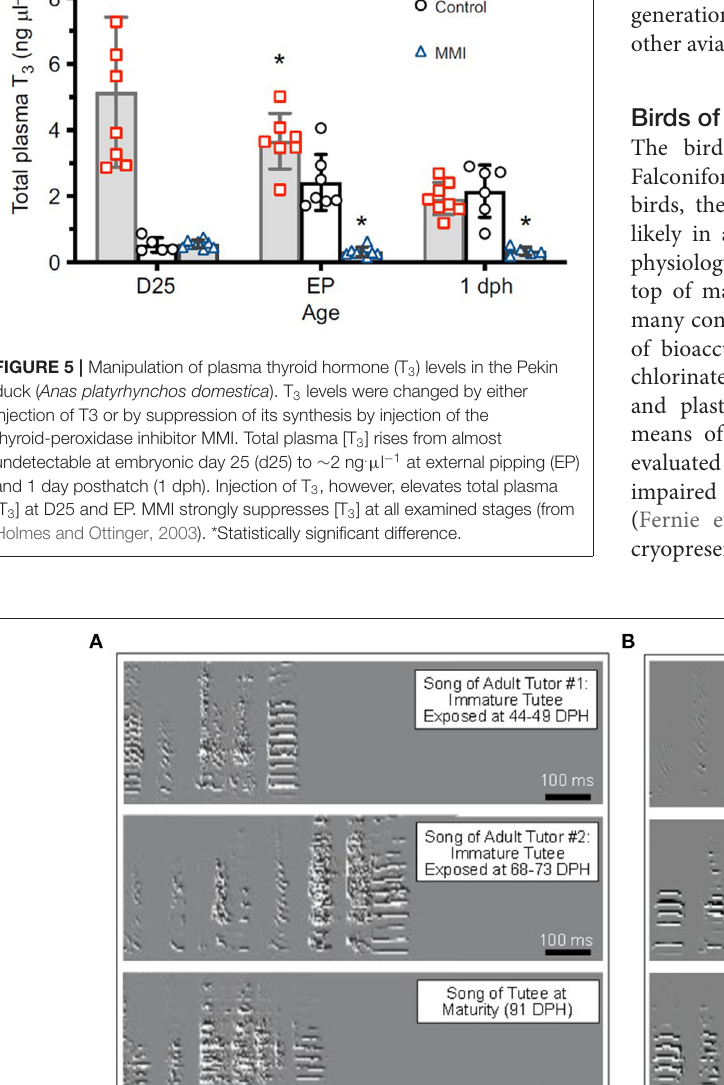
Frontiers in Physiology |